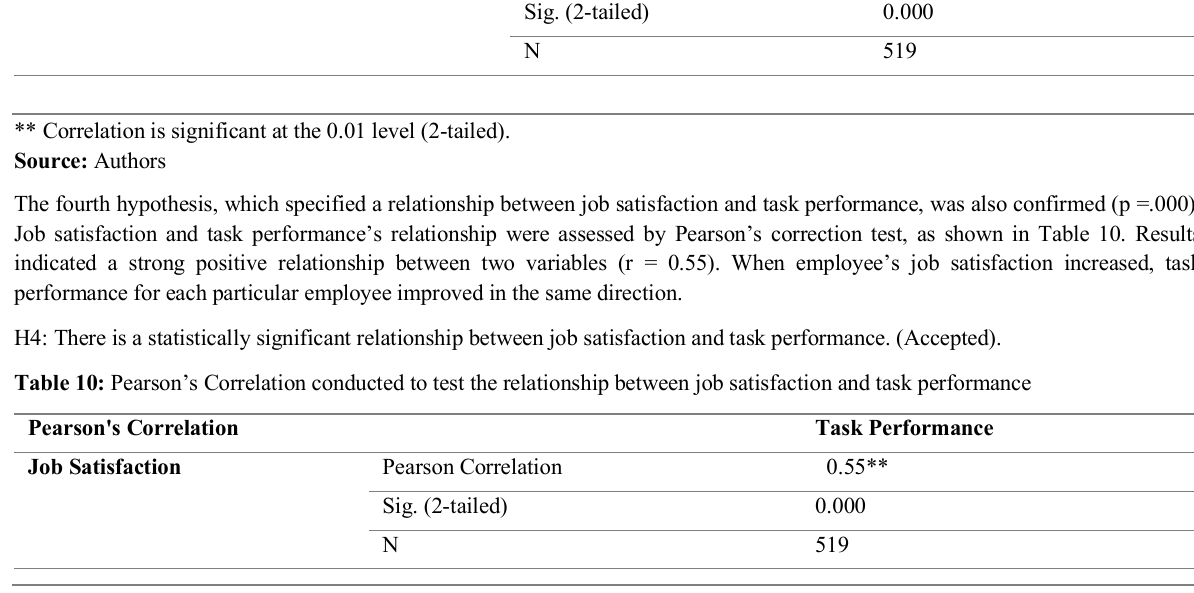
Table 9: Pearson’s Correlation conducted to test the relationship between experienced workplace fun and task performance Pearson's Correlation Task Performance Experienced Workplace Fun Pearson Correlation 0.43**